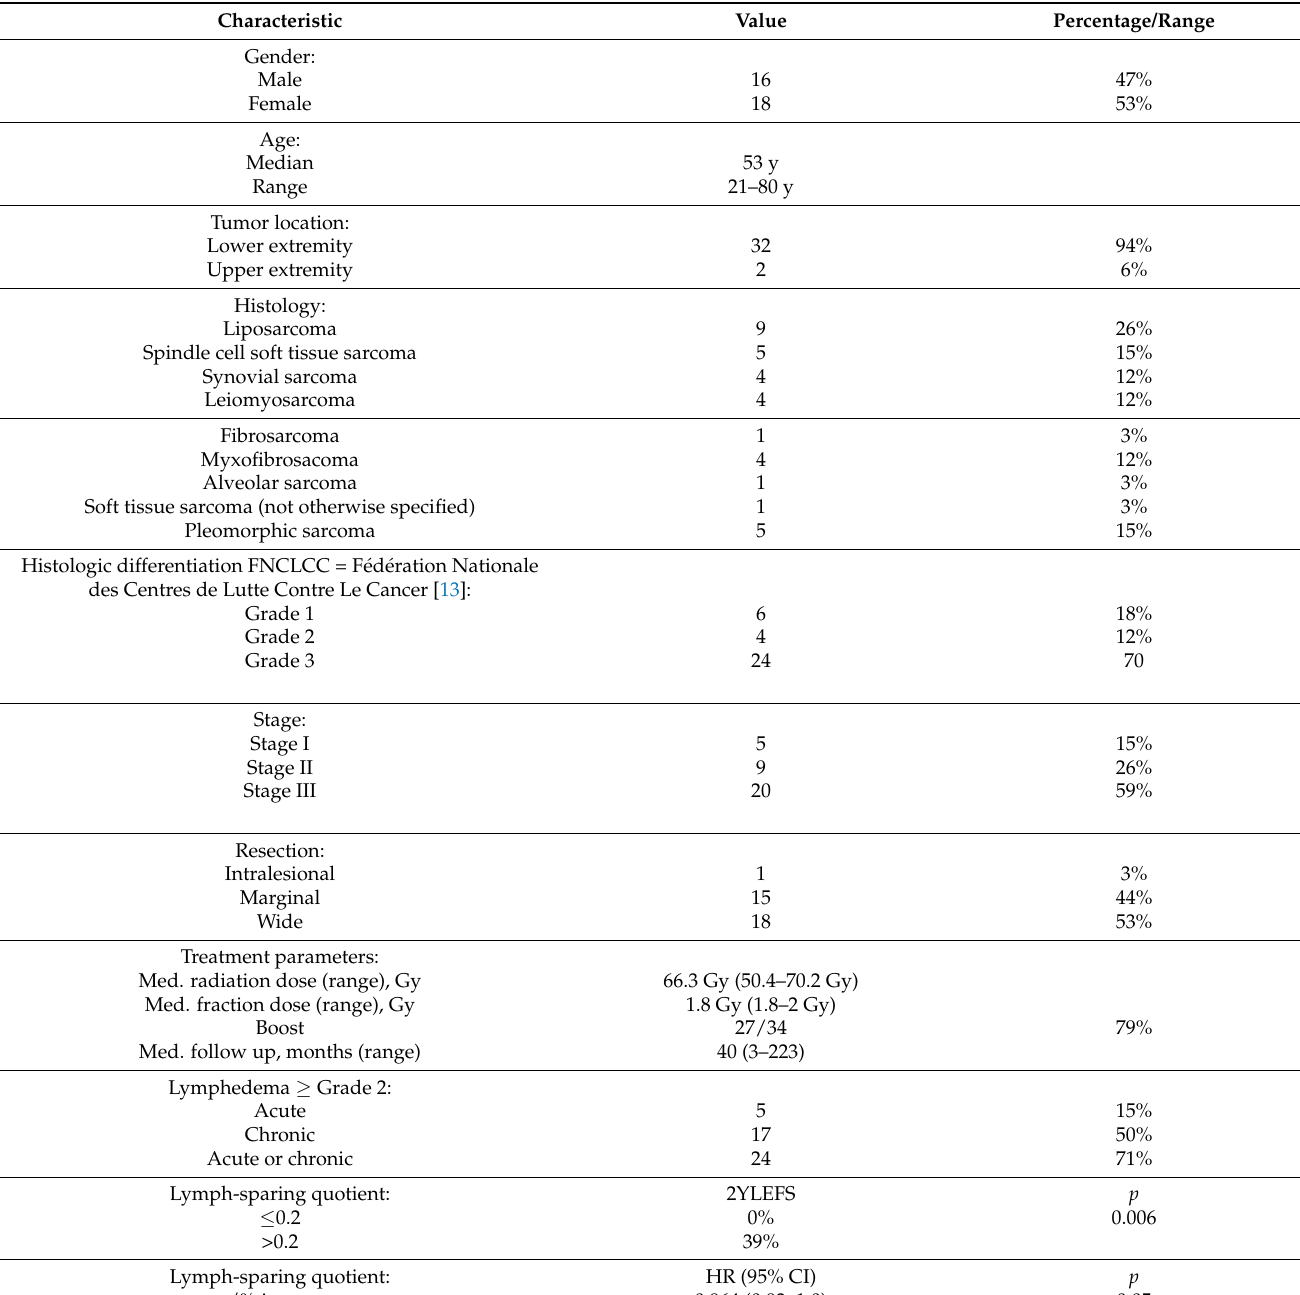
Table 1. Patient and treatment